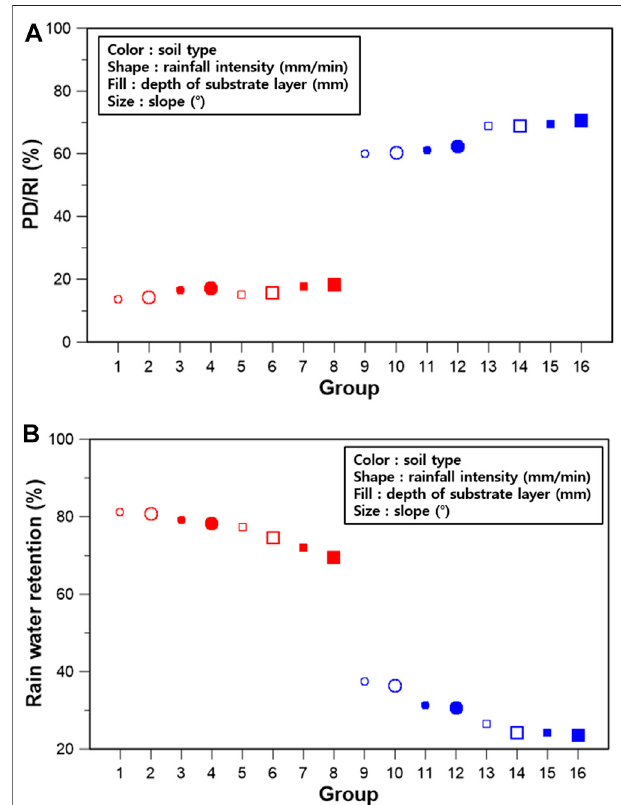
FIGURE 5 | Results of the sensitivity analysis of different factors to assess the hydrological performance of green roof systems: (A) PD/RI ratio; (B) Rainwater retention rate. Note: red-clay and blue-silty clay; circle-2.5 mm/ min and square-15.0 mm/min; open-300 mm and closed- 100 mm; small-0 degrees and large-10